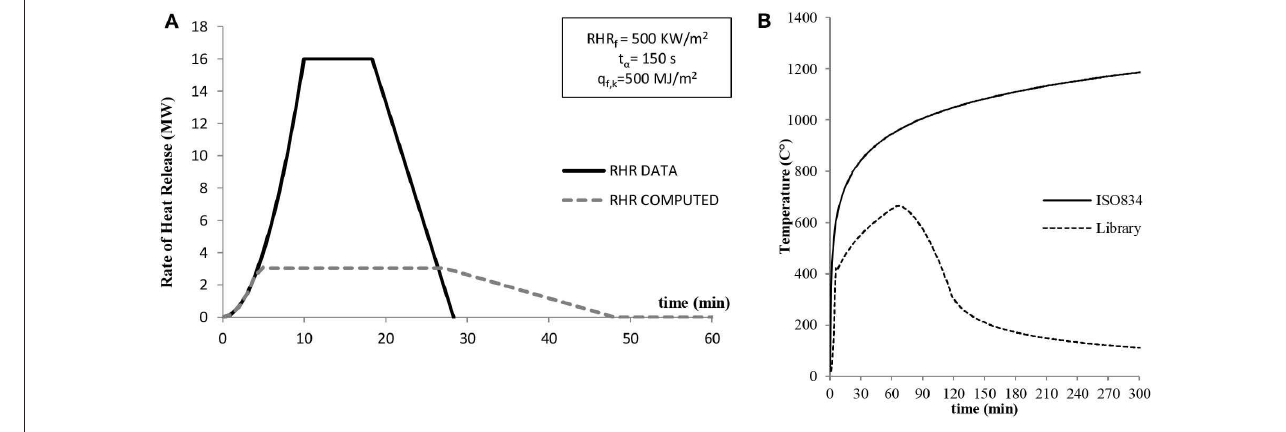
FIGURE 10 | Rate of heat release curves (A) , input fire curves (B) .